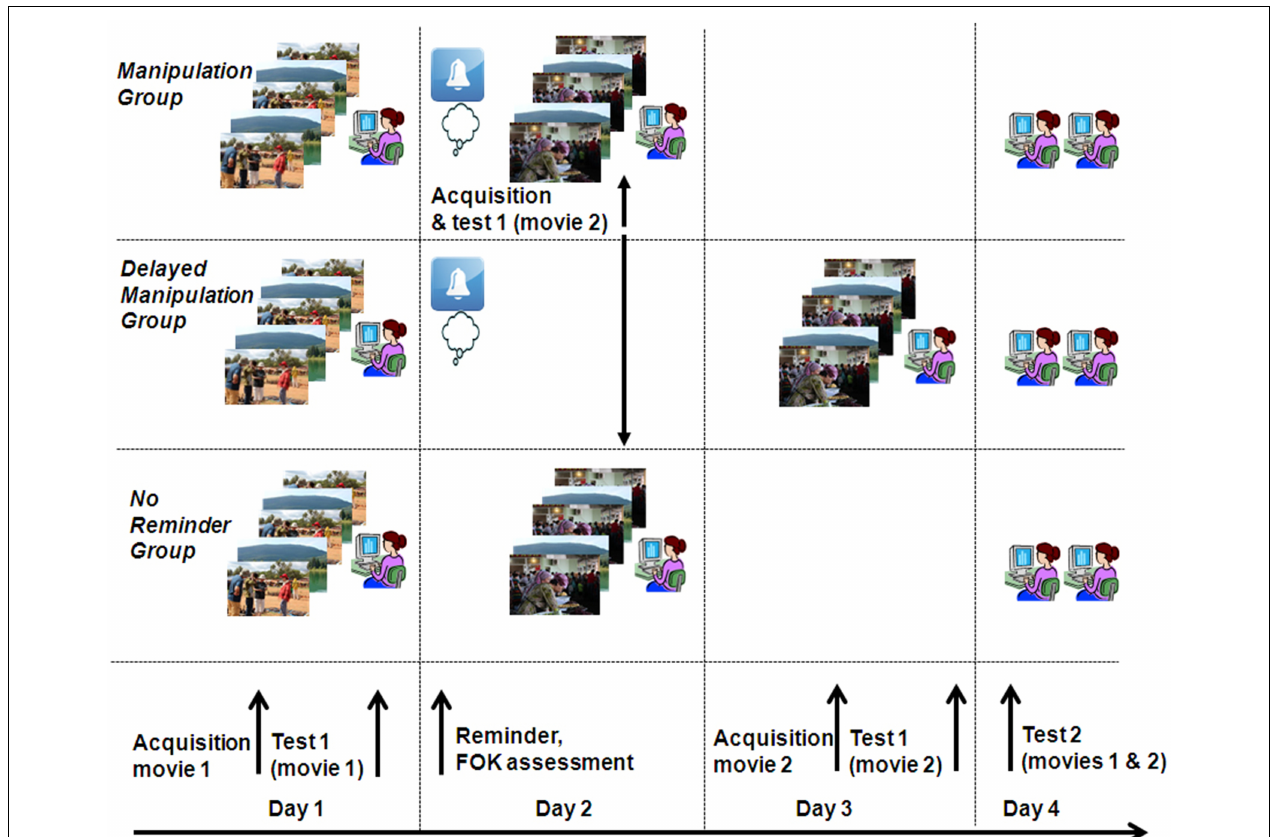
FIGURE 1 | Experimental design. Participants from all three groups watched a movie (movie 1) and were subsequently tested on their memory of it (test 1). On day 2, participants of the Manipulation and Delayed Manipulation Groups were provided with reminders regarding scenes from movie 1, to which they were asked to rate their feeling of knowing (FOK). Immediately